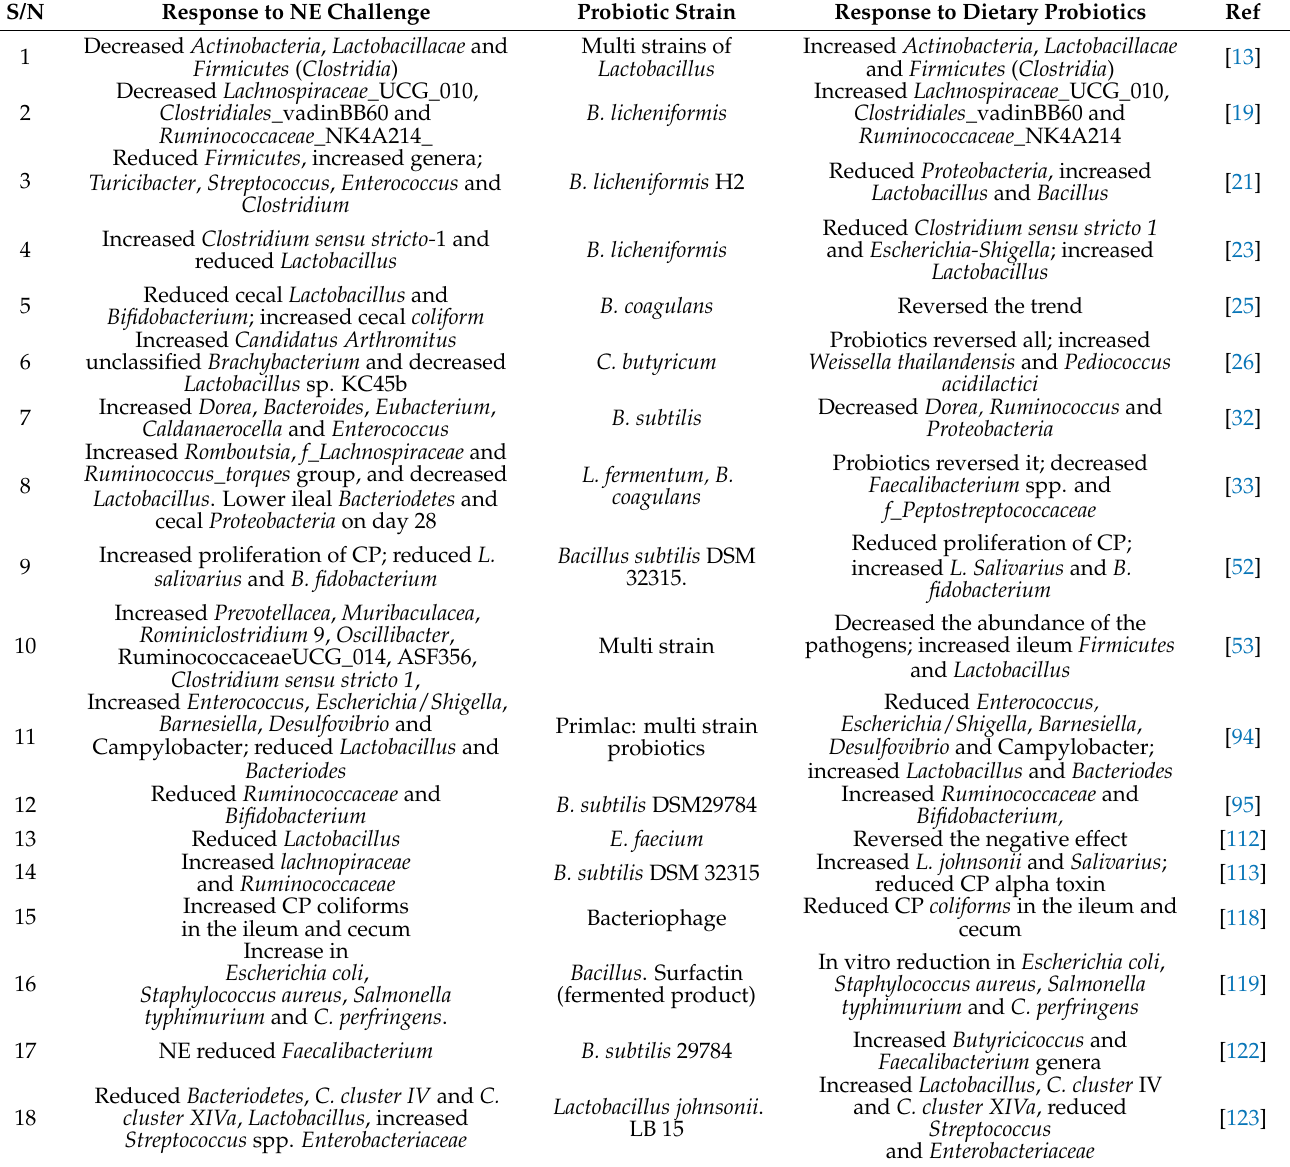
Table 6. Influence of NE challenge on gut microbiota and the modulation effect by